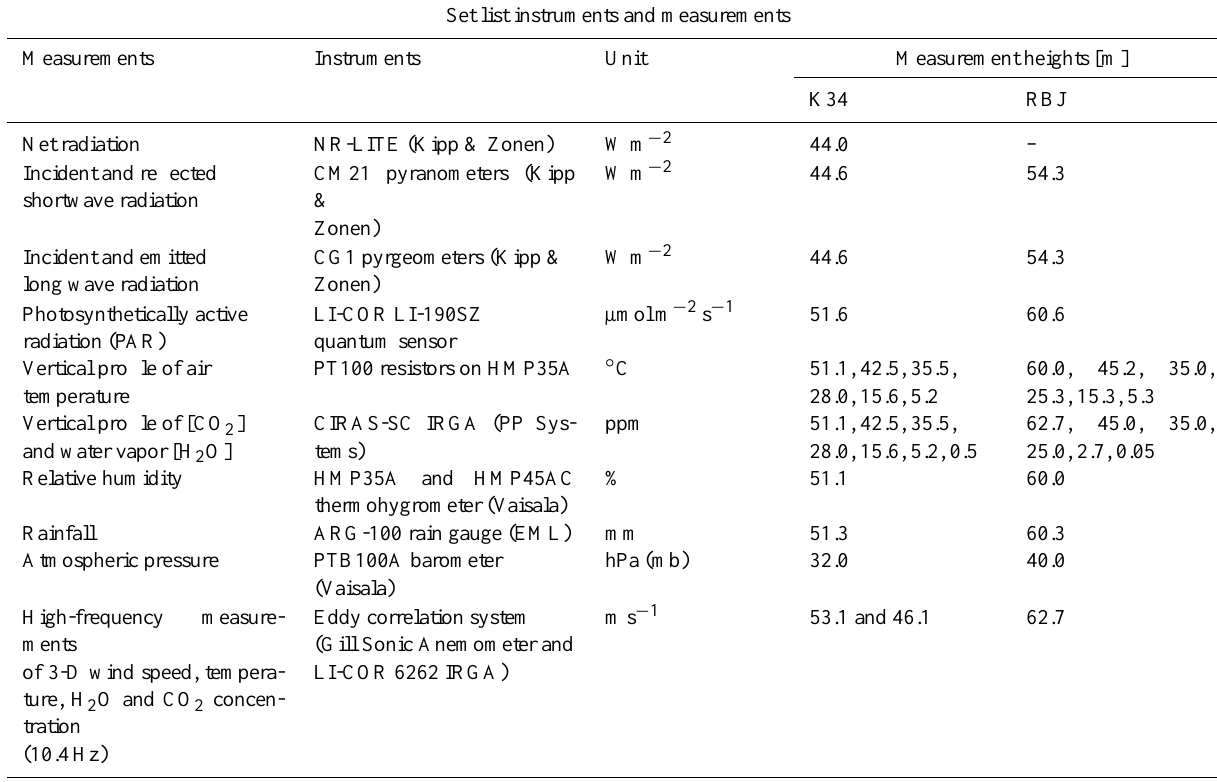
Table 1. List of measurements, instruments and measurement heights for the automatic weather station and eddy correlation instrumentation installed on the K34 /Manaus-AM and RBJ/Ji-Paraná LBA towers. Set list instruments and